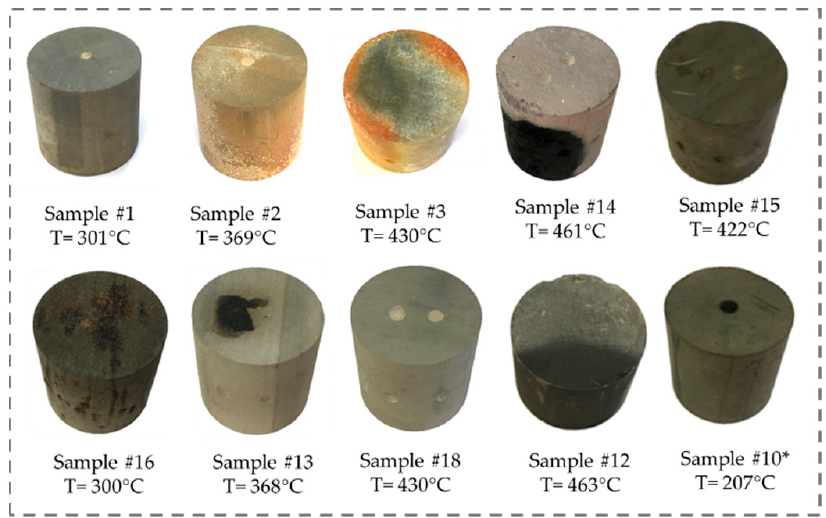
Figure 2. Photographs of cylindrical samples after the combustion tube experiment (modified after [37] ).